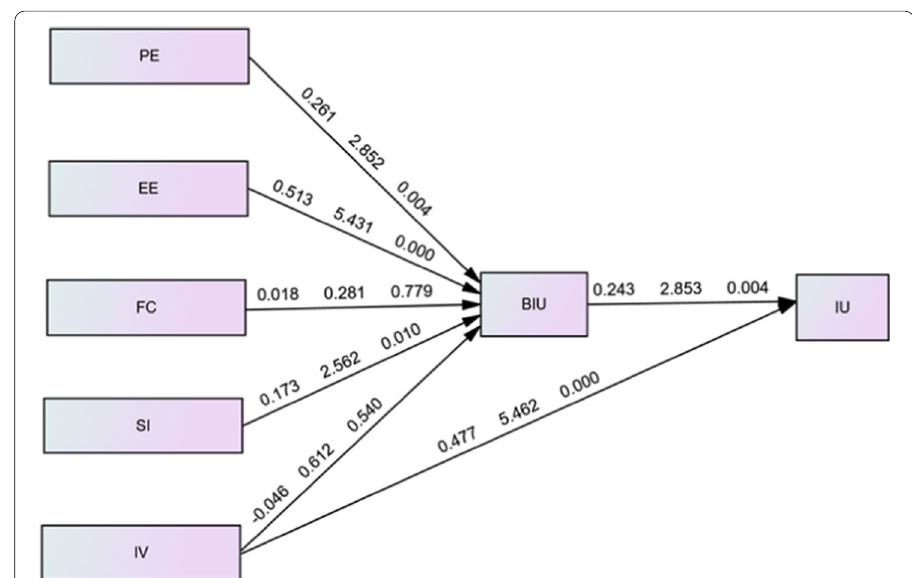
Fig. 2 Research Model showing relationships between the select constructs and the β, t, and p values for each path